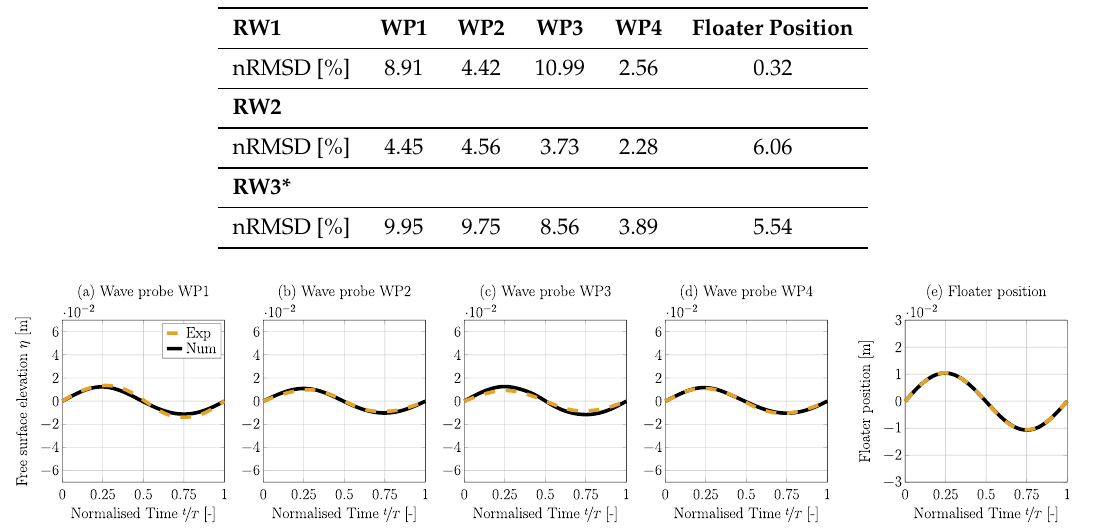
Table 6. nRMSD between the experimental and numerical free surface elevation and floater position for waves RW1–RW3*.